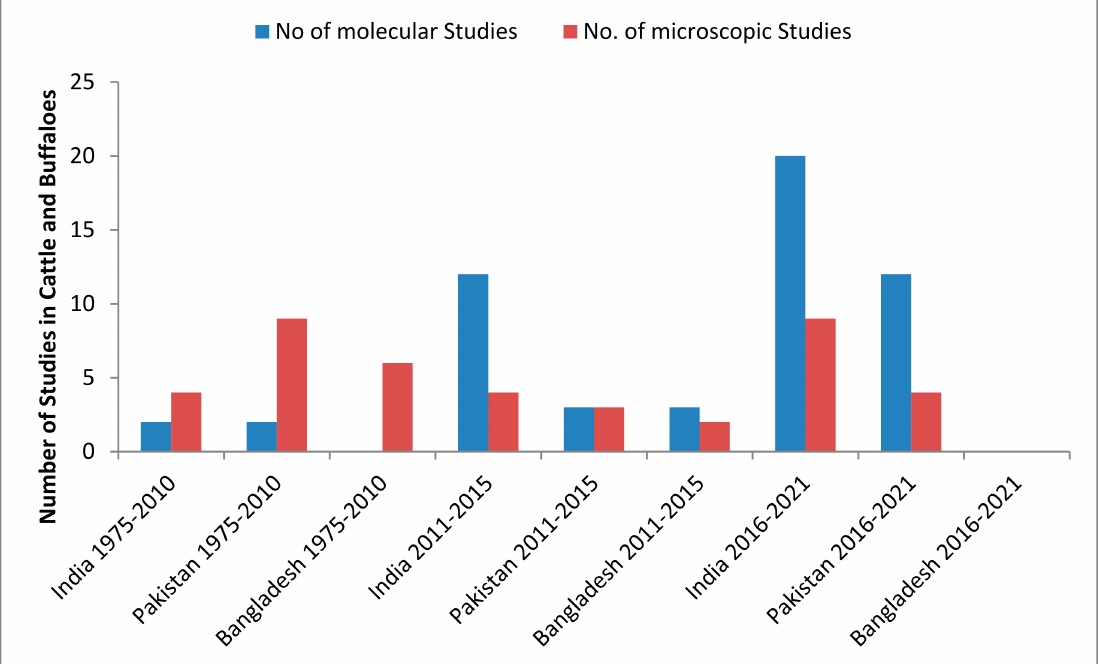
Figure 4. Comparison of the number of epidemiological studies detecting Theileria spp. in water buffalo and cattle using molecular and microscopic diagnostic methods in India, Pakistan and Bangladesh, according to three different periods between 1975 and